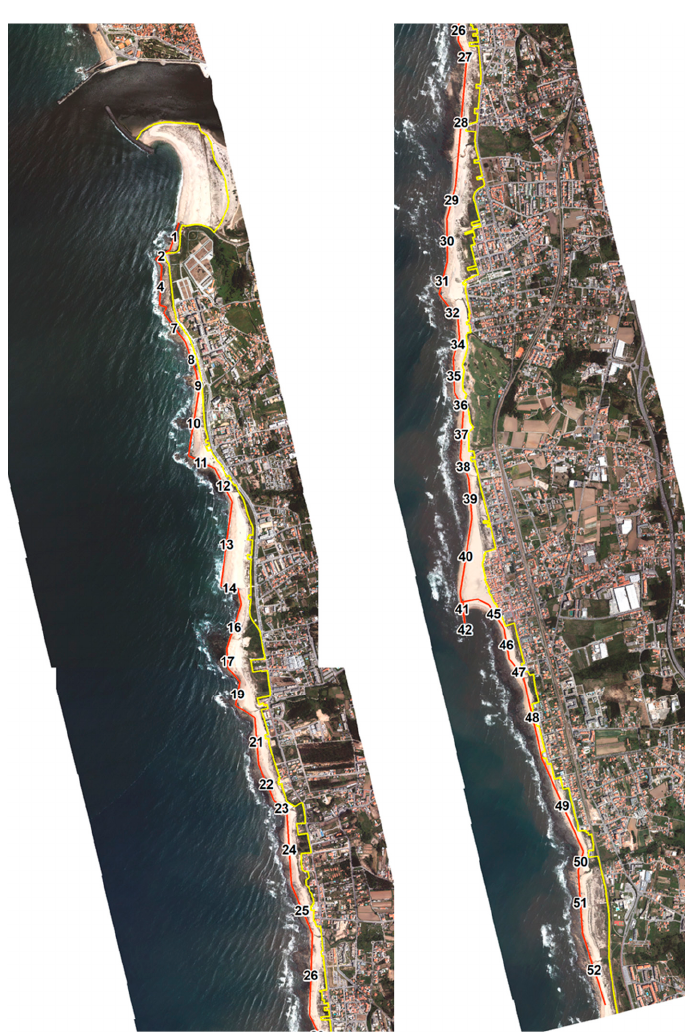
Figure 8. Orthomosaic of the aerial photographs, with the analysed coastal segments (simplified 1 m isoline in red, segments labelled with their ID numbers) and the delimitation of the beach–dune system (yellow line); segment 14 marks the Canide groyne, segments 41 and 42 mark the Aguda breakwater.